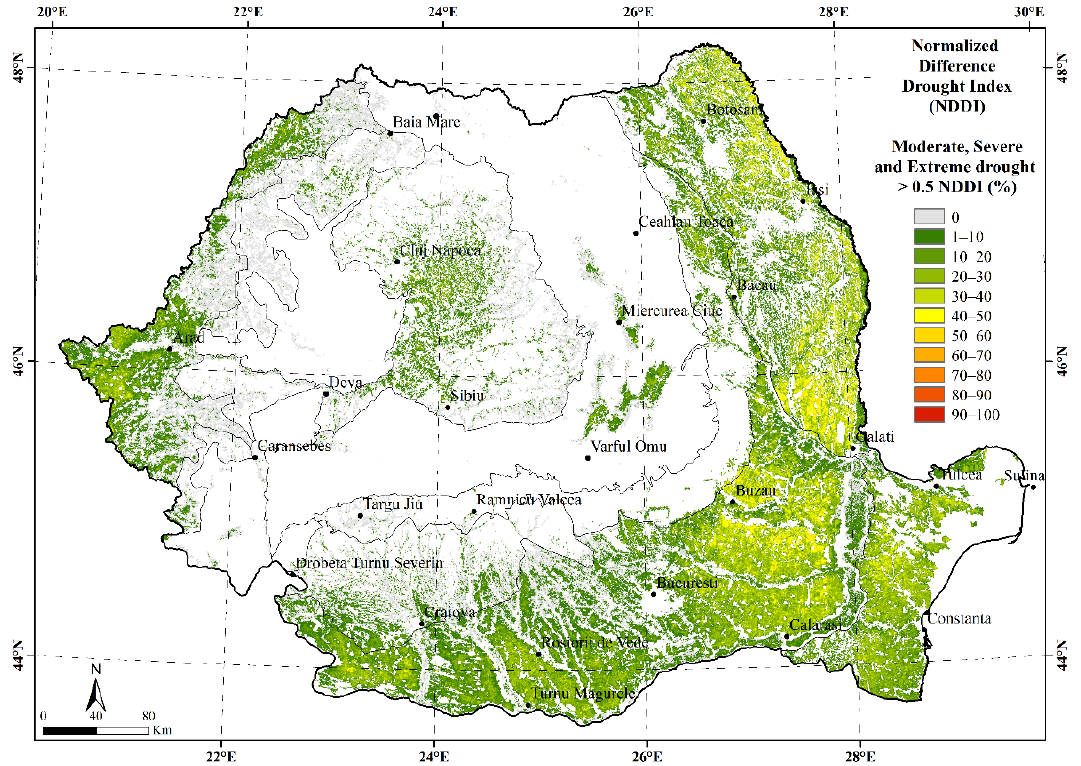
Figure 8. Spatial relative frequency of drought classes over arable lands in Romania for the seven wettest years from 2001 to 2020.